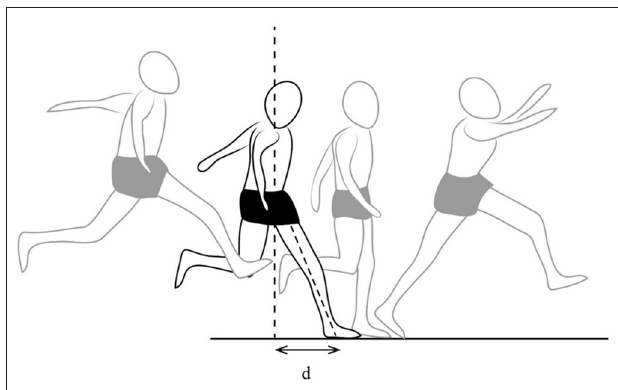
FIGURE 2 | Foot position and pelvis projection during jump receptions in triple jump. “d” is a distance between foot position and pelvis.